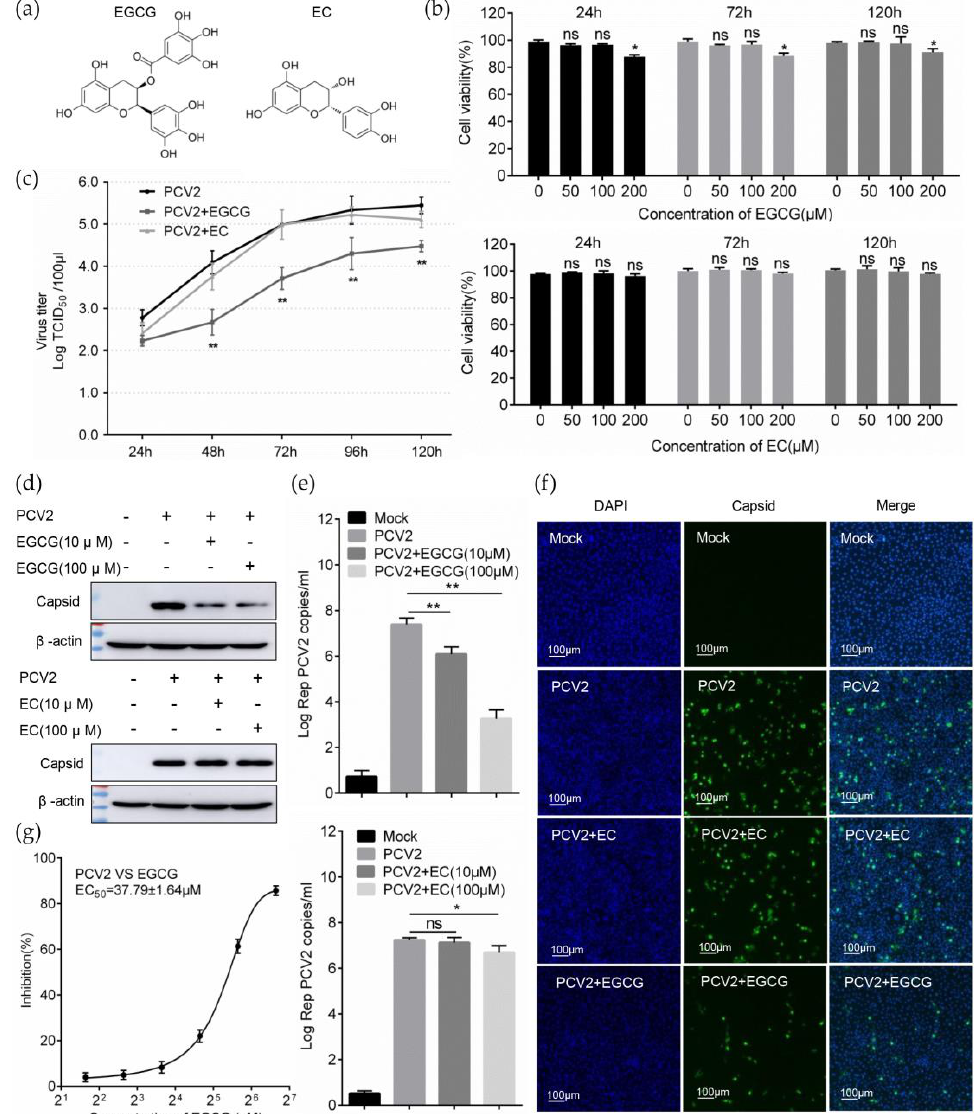
Figure 1. EGCG exhibits an anti-viral effect on PCV2 infection. ( a ) Molecular structure of EGCG and EC. ( b ) Cytotoxicity assay of soluble EGCG and EC. PK-15 cells were added with a concentration of 0, 10, 50, 100 and 200 μM EGCG or EC and cultured for 24 h, 72 h and 120 h, respectively. Cell vitality was detected by CCK8 assay and calculated as (A450 compound / A450 mock ) × 100%. ( c ) One-step growth curve of PCV2 with EGCG treatment. PK-15 cells were inoculated with PCV2 at MOI = 1.0 and cultured with 100 μM EGCG or EC treatment. TCID 50 at various time points were determined by IFA and calculated according to the Reed-Muench method. ( d – f ) EGCG inhibited the infectivity of PCV2. PK-15 cells were inoculated with PCV2 at MOI = 1.0 with EGCG or EC addition. ( d ) The expression inhibition of PCV2 capsid protein was detected by immunoblotting at 72 hpi. ( e ) PCV2 genome copies were measured by real-time PCR. ( f ) Indirect IFA detection of PCV2 infected cells. ( g ) Dose response curve and EC 50 of the EGCG’s antiviral effect on PCV2. The mean ± SD of three independent experiments was compared using Student’s t -test (n.s., not significant; * p < 0.05; ** p < 0.01).